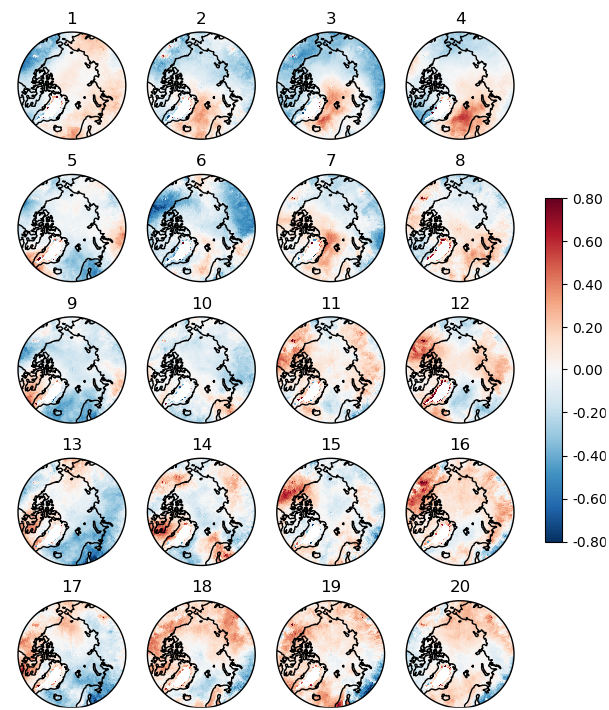
Figure A2. Specific humidity anomalies (gkg − 1 ) at 850hPa based on AIRS data for the 20 circulation types.